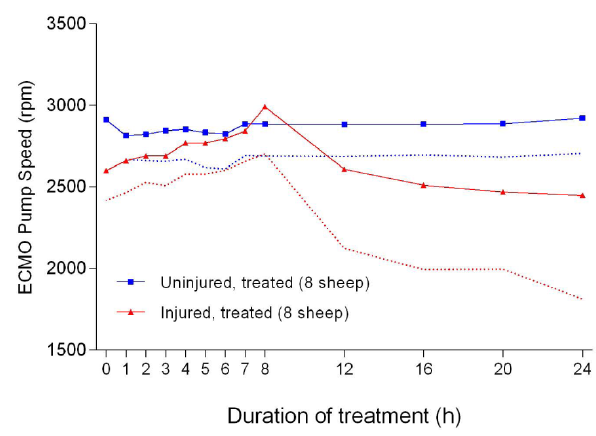
controls.Figure 46. Extracorporeal life support pump speed (Mean ± SD) for smoke and non-smoke injured sheep that received treatment. Dotted lines represent one-sided error bars.